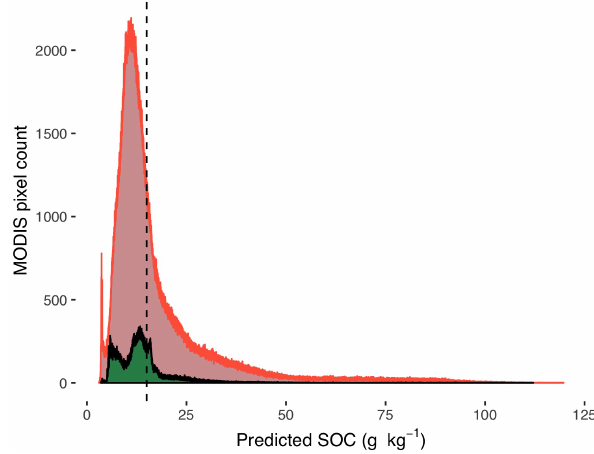
Figure 3. Histograms showing the distribution of SOC in Turkana County (green) versus the rest of Kenya (red). The vertical dashed line represents a SOC concentration of 15gkg − 1